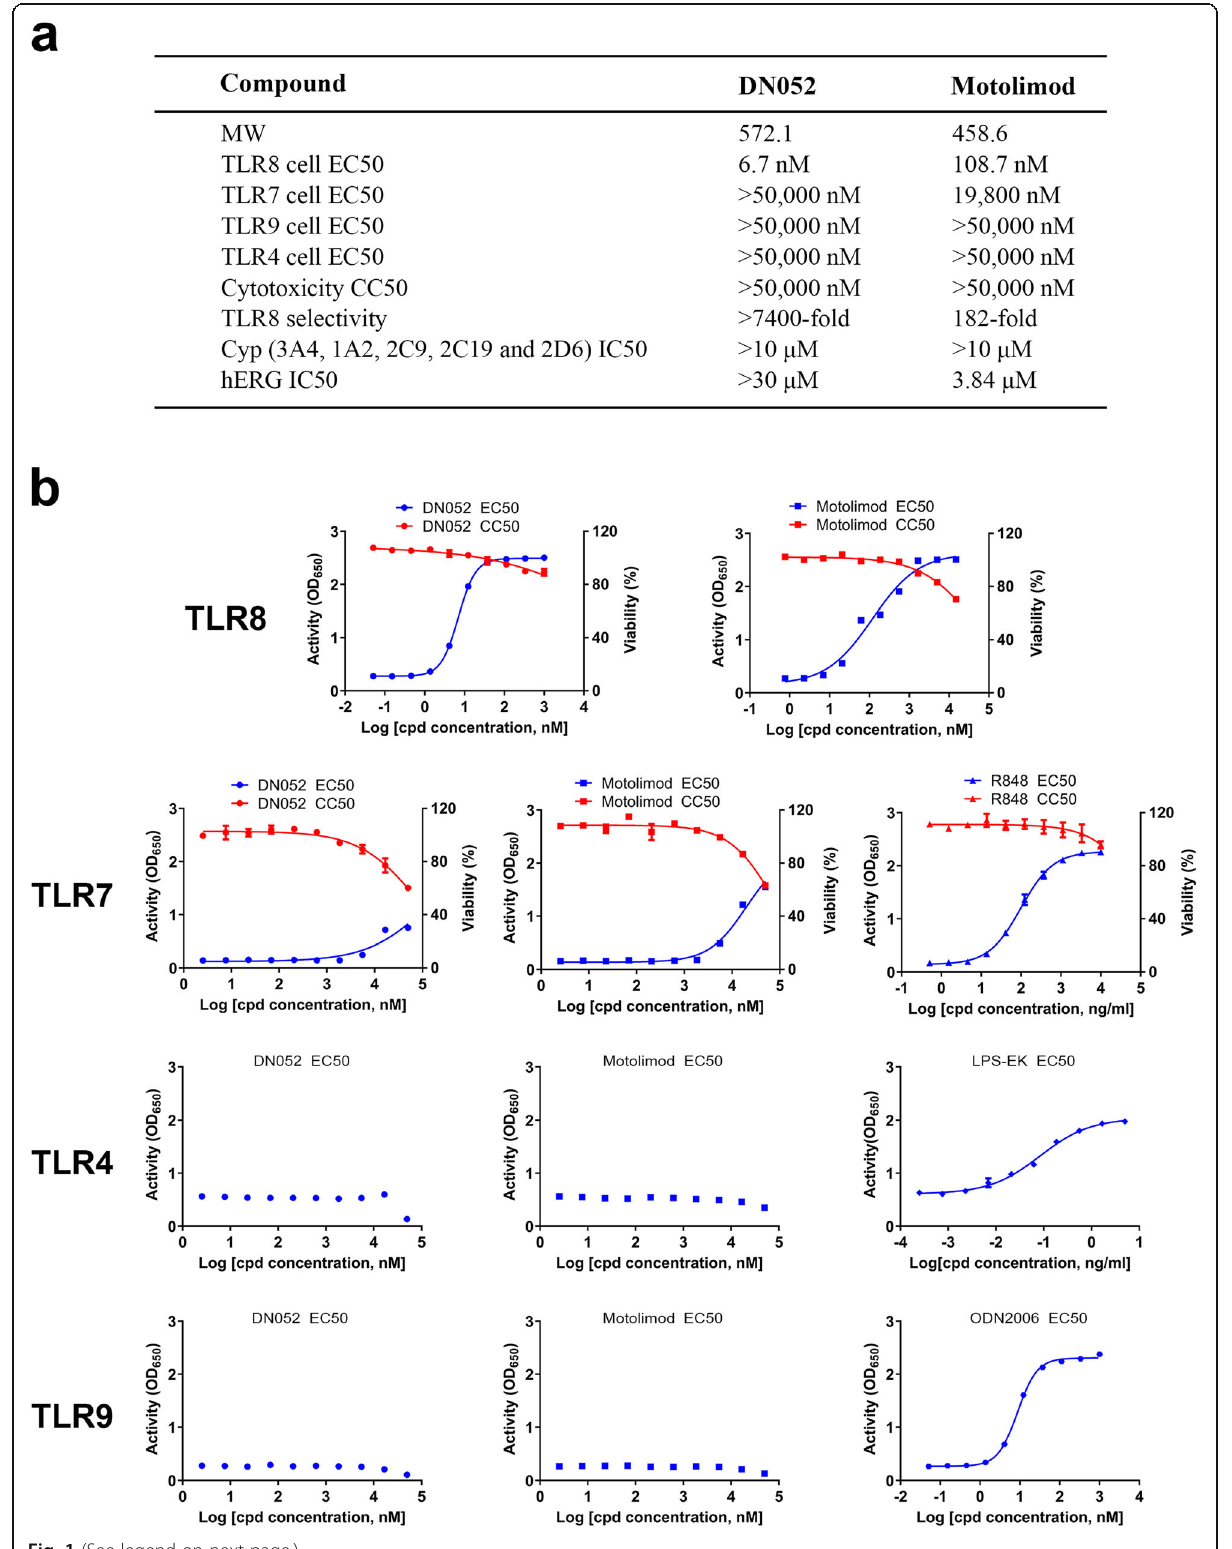
Fig. 1 (See legend on next